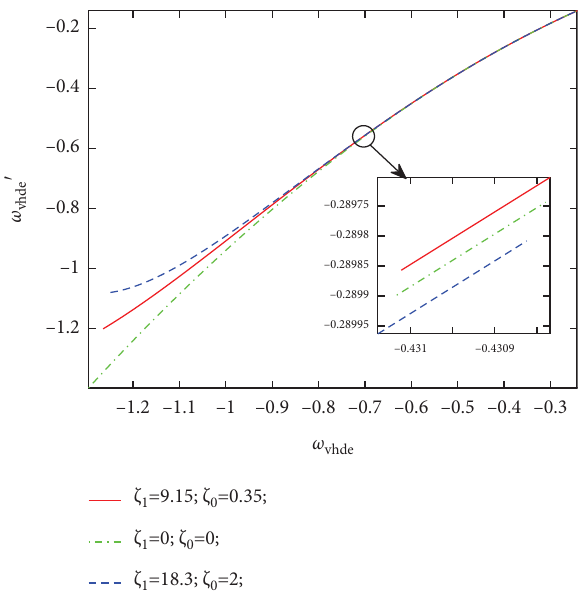
Figure 19: EoS plane ( ω